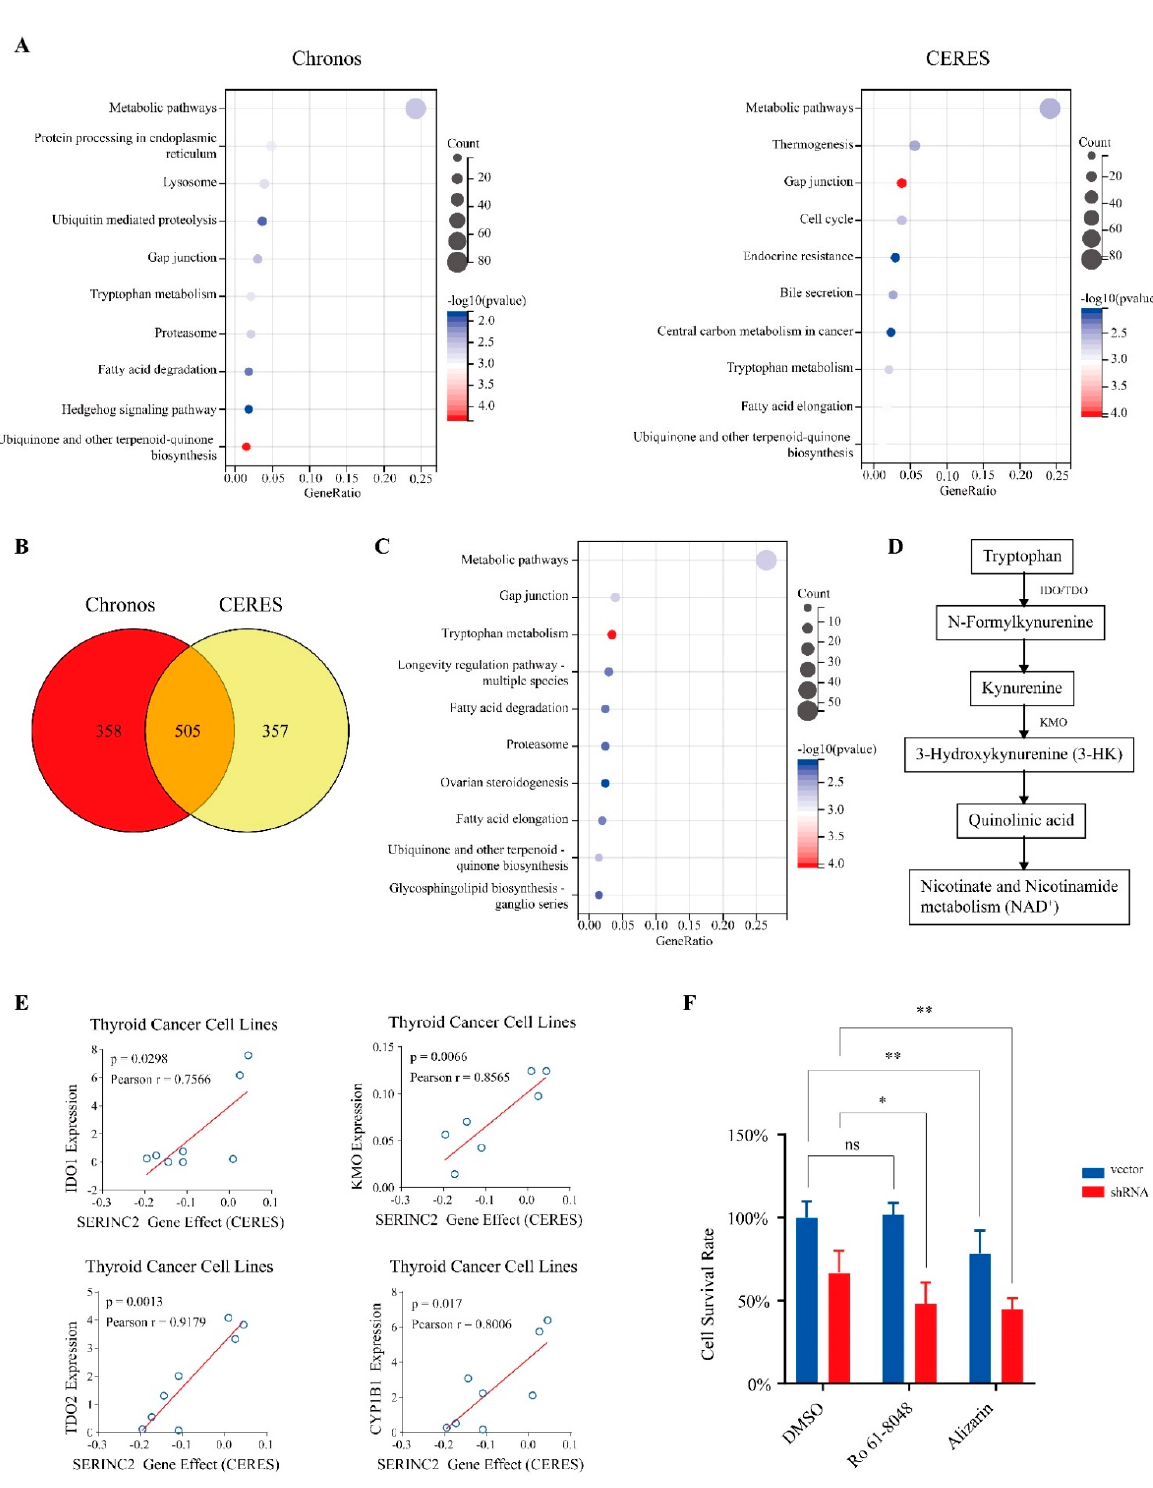
Figure 6. Activation of tryptophan metabolic pathways reduces the dependence on SERINC2 in thyroid cancer. ( A ) KEGG enrichment analysis results of genes selected by CERES and Chronos. ( B , C ) The intersection and KEGG enrichment analysis result of gene sets selected from CERES and Chronos. ( D ) Brief schematic diagram of the tryptophan-kynurenine metabolic pathway from KEGG. ( E ) The fitting line for the gene expression and SERINC2 gene effect of IDO1, TDO2, KMO, and CYP1B1. ( F ) TPC-1 cells were treated with 20nM of the KMO inhibitor Ro 61-8048 and 5 µ M of CYP1B1 inhibitor Alizarin after being transfected with shRNA for 24 h, followed by viability measurement with CCK8. Quantitative results are shown in bar graph as mean ± SEM. * p < 0.05, ** p <